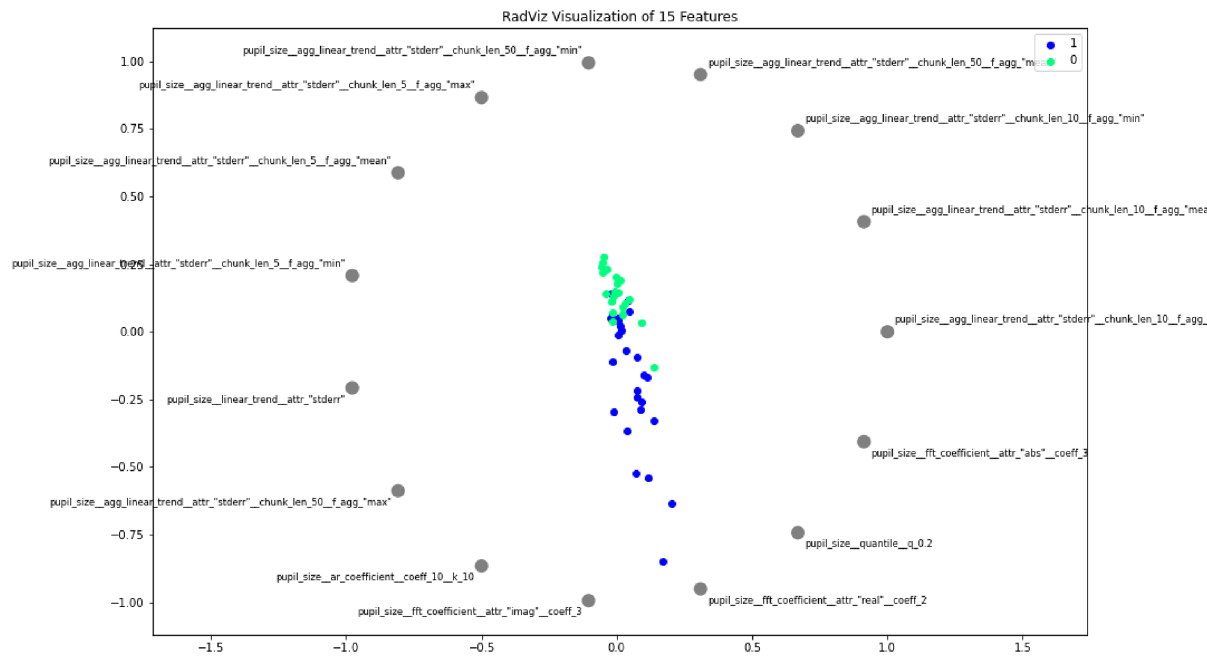
Figure 4. RadViz visualization of filtered features.